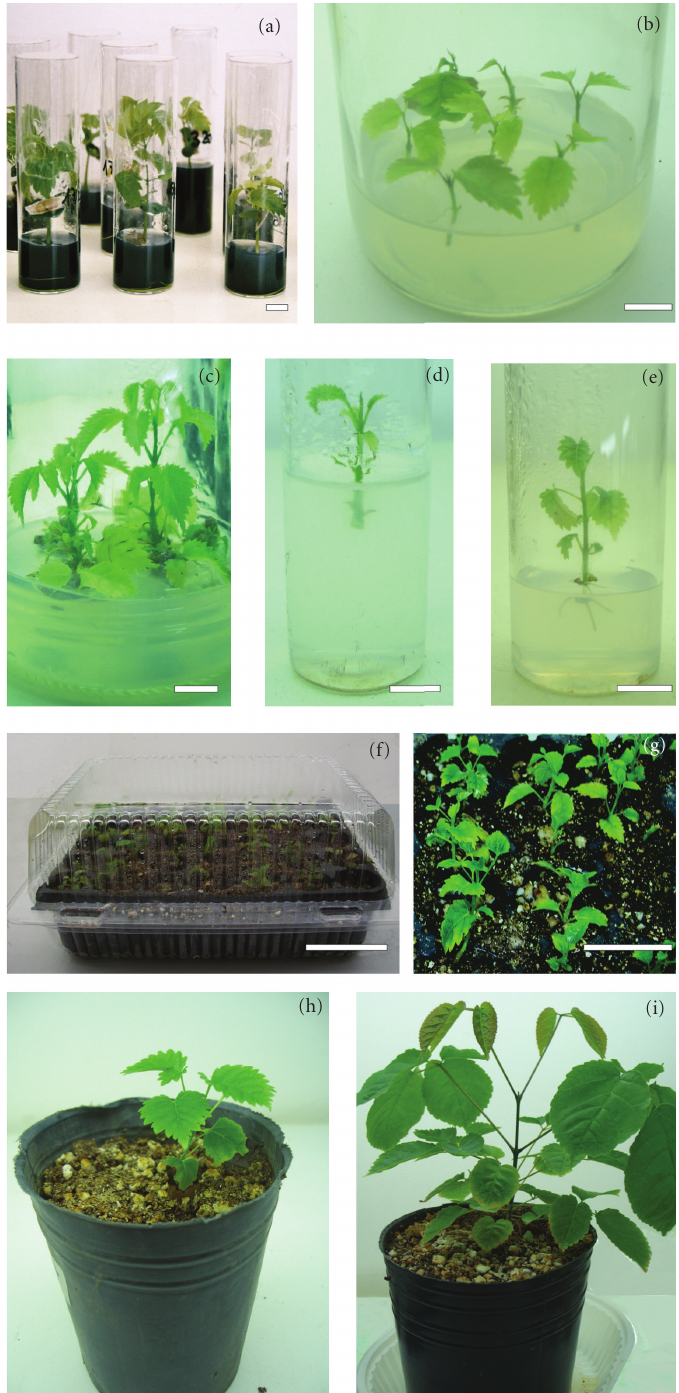
Figure 1: In vitro propagation of Handroanthus impetiginosus. Initiation stage: (a) germinated seedlings. Multiplication stage: (b) initial explants, (c) shoot after 30 days culture. Rooting stage: (d) initial shoot, and (e) rooted shoot. Acclimatization stage: (f) plantlets in plastic tray for initial stage of acclimatization, (g) detail of plantlets inside plastic tray, (h) plant acclimatization in plastic pot after 90 days culture, and (i) acclimatized plant after one-year culture. Bars (a)–(e): 1cm, (f)–(i):